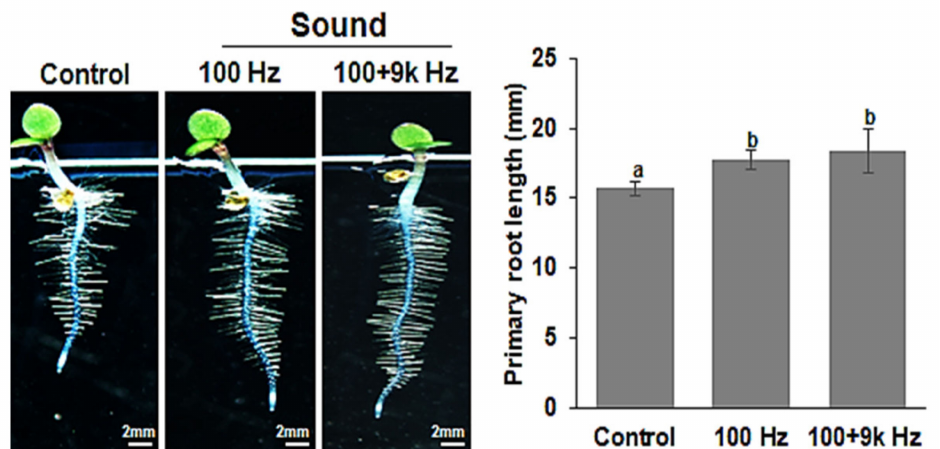
Figure 1. Sound wave treatment promotion of Arabidopsis thaliana root growth. Seeds were exposed to 100 or 100 + 9k Hz sound waves and seedlings were observed on the 5th day after sowing using an optical microscope ( × 10; left panel ). The graph shows the average primary root length for each treatment ( ± standard error). Different letters above the bars indicate significantly different mean values ( p < 0.05) based on Duncan’s multiple range test. Scale bars represent 2 mm. Images show representative individuals of at least 50 seedlings in three or more replicate